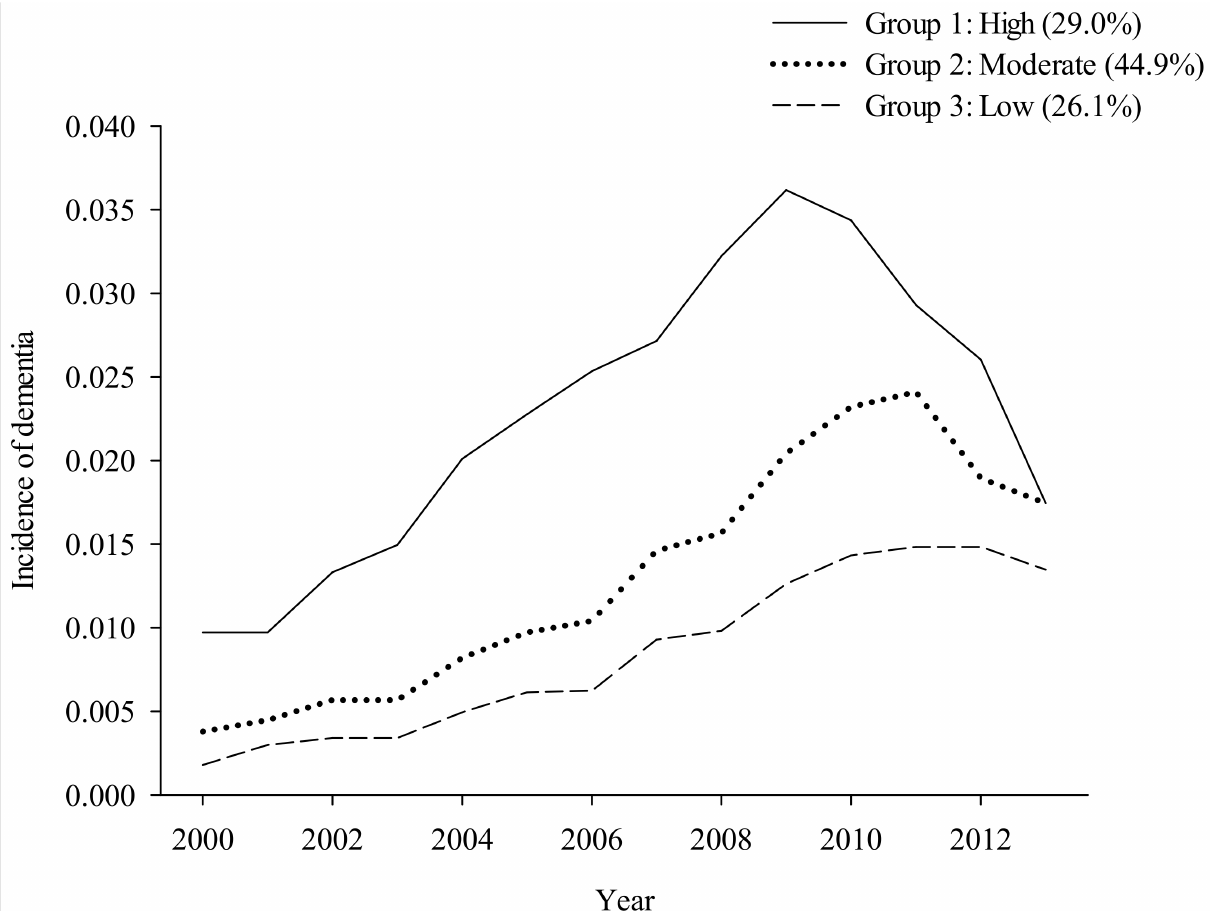
Figure 1. Trajectory of dementia incidence between 2000–2013. Group 1: high dementia incidence (29.0% probability); Group 2: moderate dementia incidence (44.9% probability); Group 3: low dementia incidence (26.1%